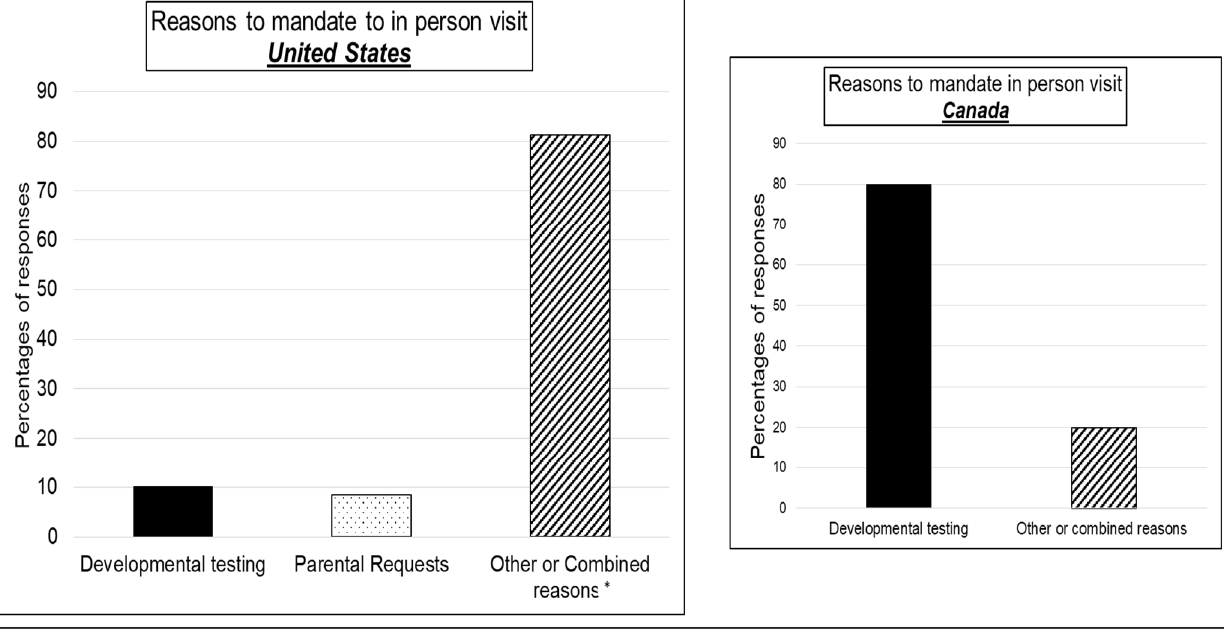
Figure 3. Criteria to mandate in-person HRIF clinic visits.